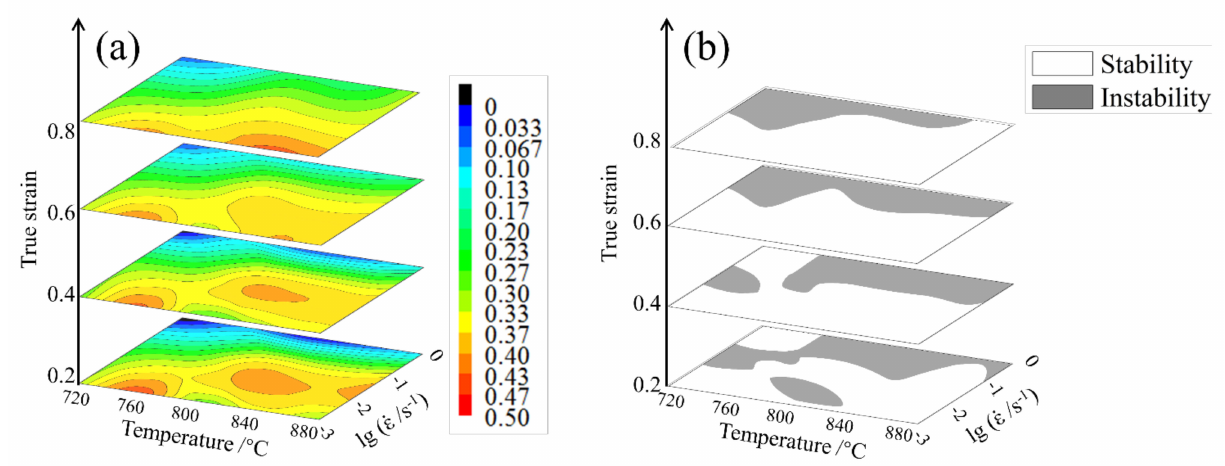
Figure 4. ( a ) Efficiency of power dissipation and ( b ) flow